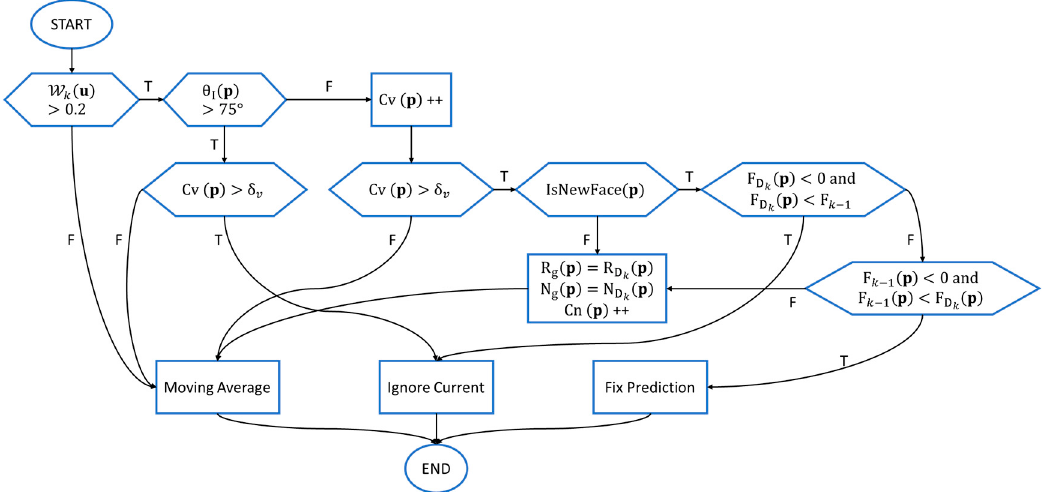
Figure 7. Description of our TSDF fusion algorithm as a flowchart.